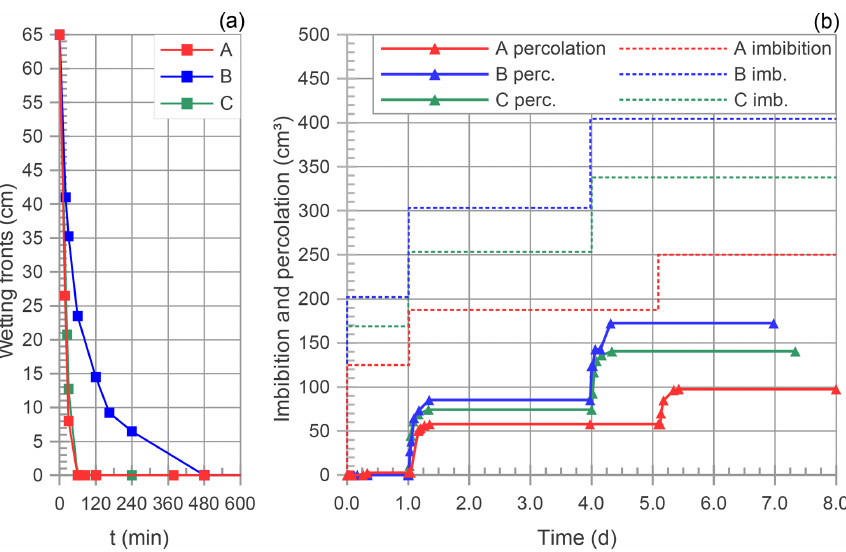
Figure 8. Measures collected during the three repetitions of the third experiment: depth of the imbibition fronts (a) and volumes of imbibition and percolation (b) . The unitary volume V i of a vial was estimated to be equal to V i = 31.3, 50.5 and 41.0cm 3 for soil A, B and C, respectively, according to the procedure described in Sect. 5. A, B, C: soil identification; (cid:3) : downward moving water front; (cid:52) : percolation volume; dashed line: imbibition